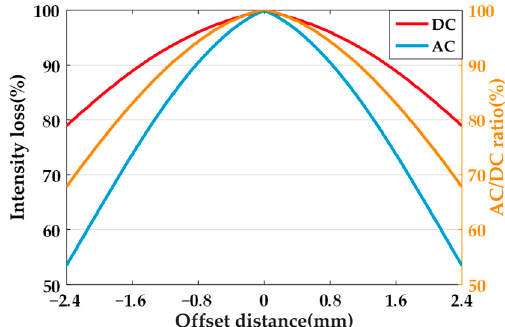
Figure 4. Simulation results of normalized DC and AC intensity, as well as the AC/DC ratio.